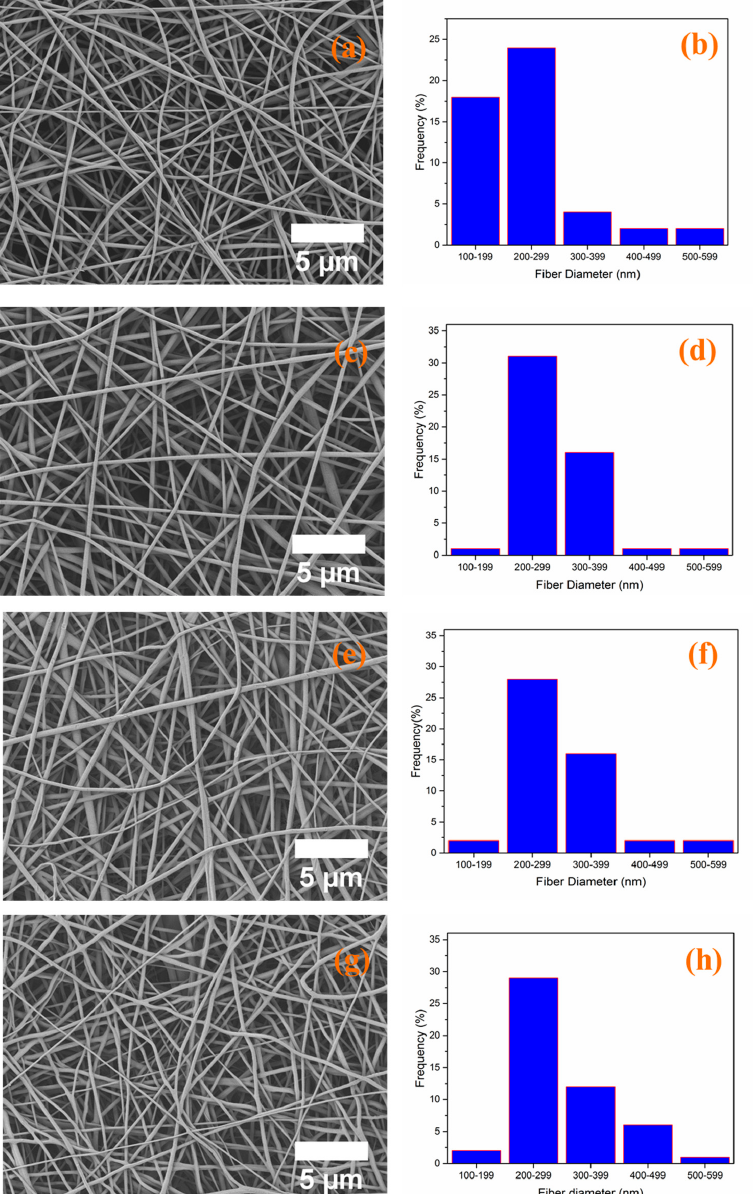
Figure 2. The morphology and fiber diameter distribution of poly( ε -caprolactone) gelatin (PCL-GEL) ( a , b ), PCL-GEL / clove essential oil (CLV)1.5 ( c , d ), PCL-GEL / CLV3 ( e , f ), and PCL-GEL / CLV6 ( g , h ) nanofiber mats,